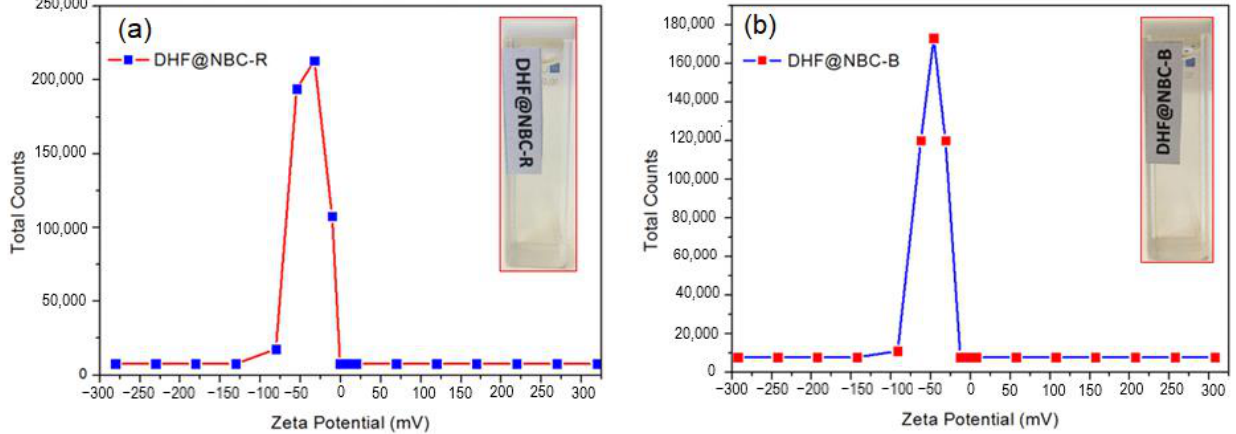
Figure 11. Dispersibility of DHF@NBC-R ( a ) and DHF@NBC-B ( b ) in deionized water by evaluation of the corresponding zeta potential values.